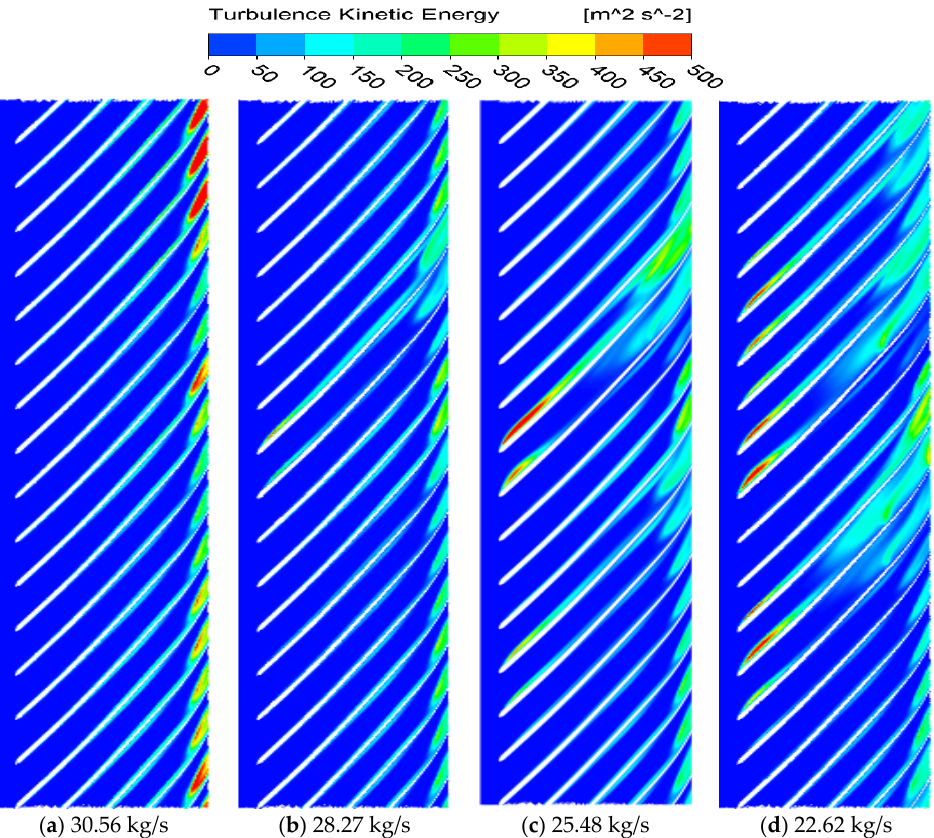
Figure 7. Comparison of turbulent kinetic energy at 50% blade height under four different mass- flow rates.